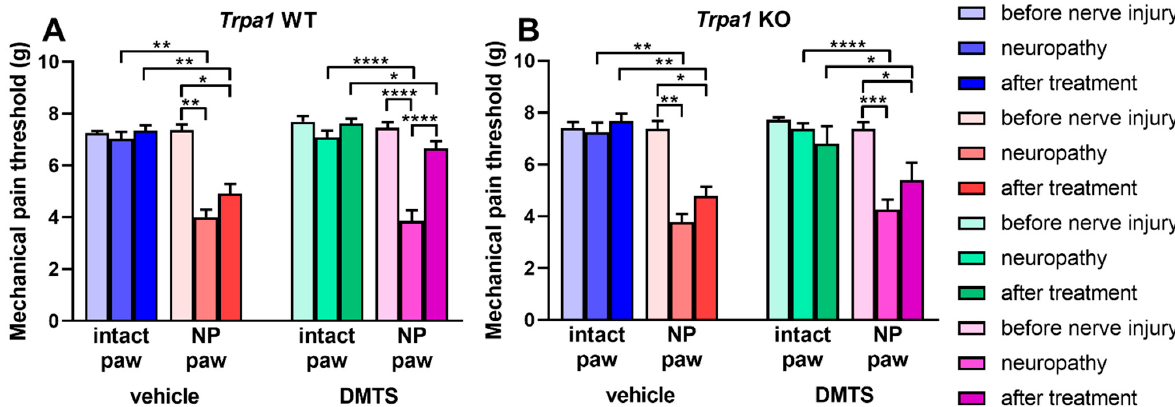
Figure 2. DMTS alleviates mechanical hyperalgesia in the hind paws Trpa1 WT animals. Mechanical pain threshold of the hind paws of Trpa1 WT ( A ) and KO ( B ) animals with unilateral sciatic nerve lesion before surgery, after neuropathy has developed and after vehicle or DMTS treatment. n = 6–8; one-way analysis of variance (ANOVA) followed by Tukey’s tests; * p < 0.05, ** p < 0.01, *** p < 0.001, **** p < 0.0001 vs. indicated groups. NP: neuropathic side (right).